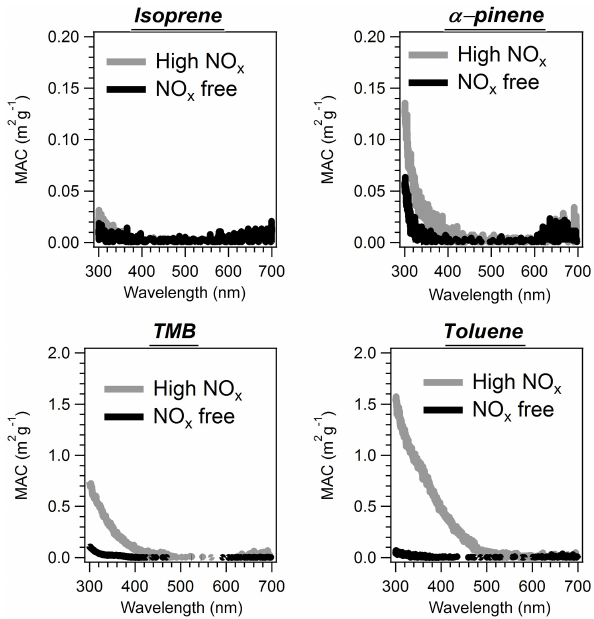
Figure 1. MAC values for SOA formed under NO x -free and high- NO x conditions, from isoprene, α -pinene, TMB, and toluene. Note the 10 × difference in scale between the terpene and aromatic pre- cursors. The MAC values shown in this figure are tabulated in the Supplement (Table S1).